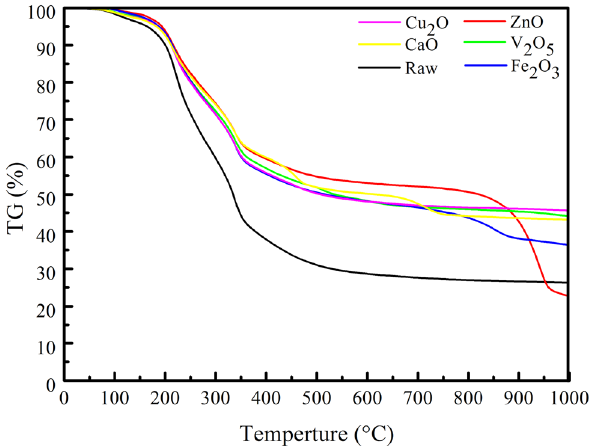
Figure 2: DTG curves of dry navel orange peel for di ff erent metal oxides in argon